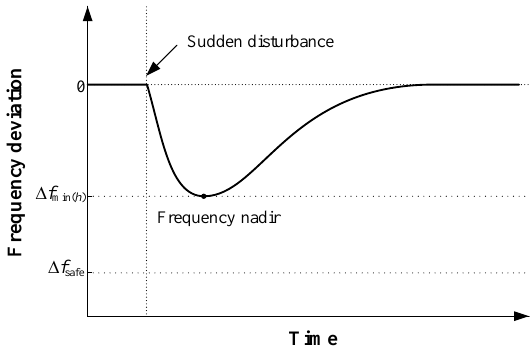
Figure 2. The frequency deviation on a supposed disturbance.